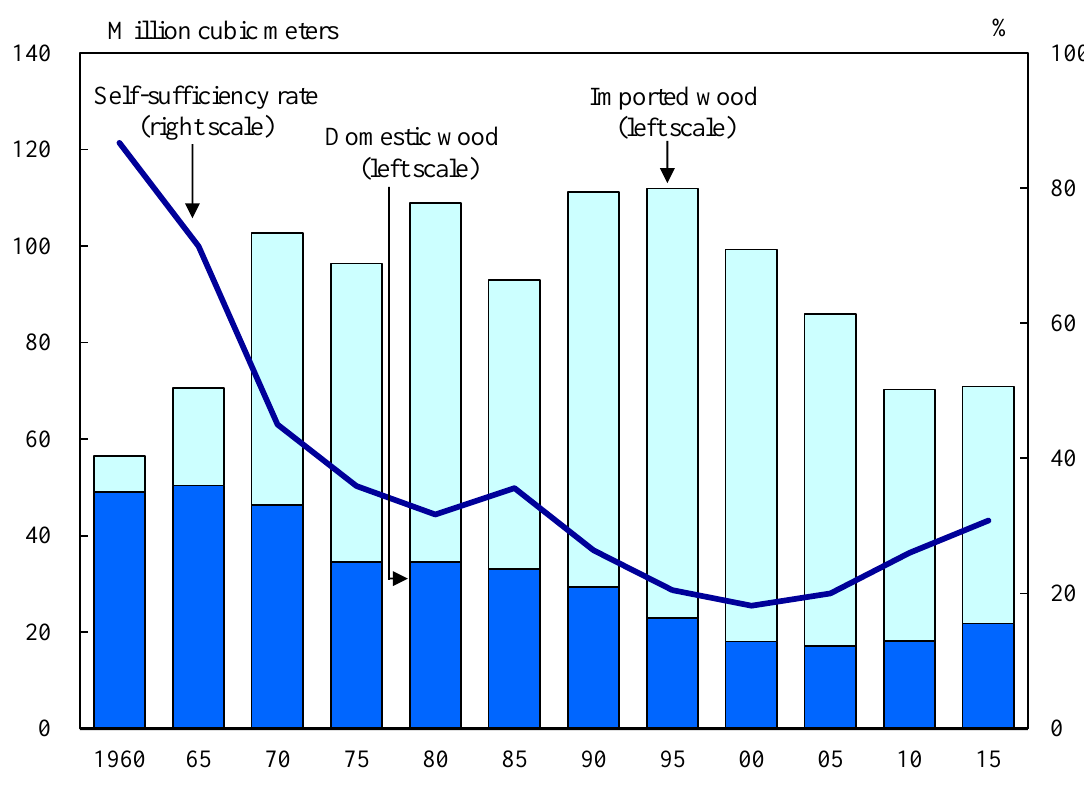
Industrial Wood Supply and Self-Sufficiency Rate